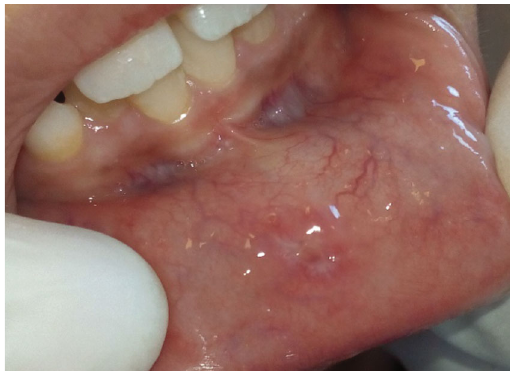
Figure 2: Diode laser tip handled around the lesion.